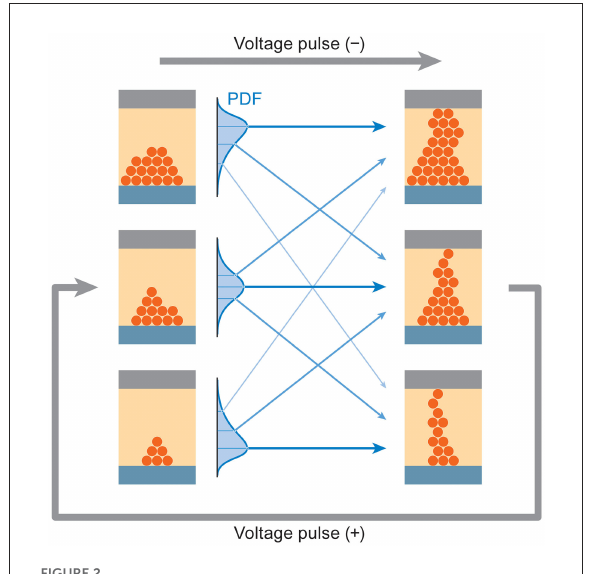
FIGURE2 Resistance states reached in a synaptic ReRAM device through application of voltage pulses exhibit a probabilistic dependence on past states, leading to long-range correlations that also involve other parameters such as the voltage thresholds required for switching. Starting with effectively infinite state possibilities, represented by the three cells on the left, an applied voltage pulse brings about a set of transition probabilities to many possible future states